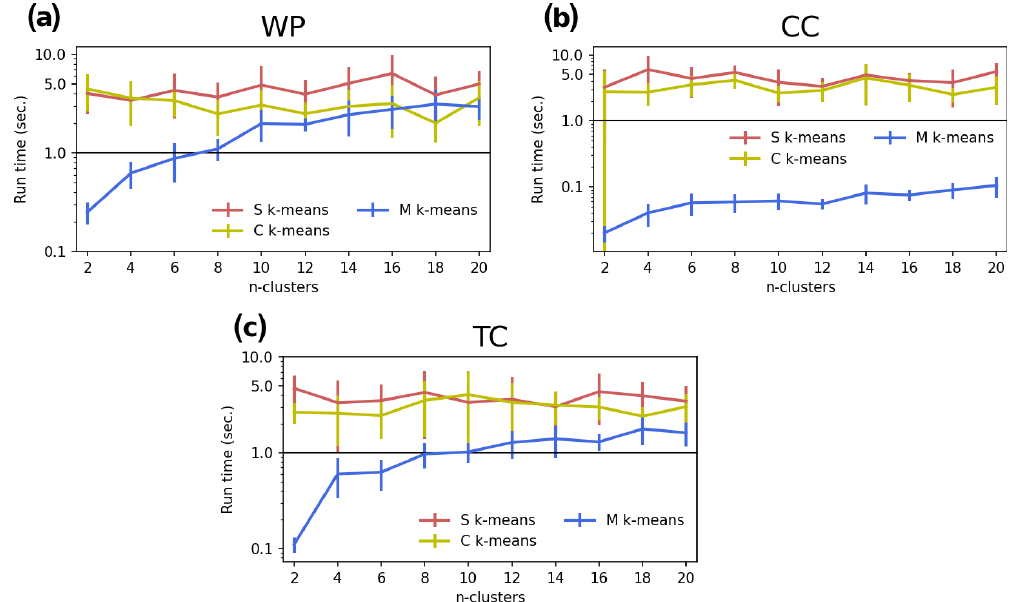
Figure 9. Comparison of the run time (in seconds) of S, C, E, and M k -means for k = 2, 4, ... , 20 for three demonstration experiments: WP (a) , CC (b) , and TC (c) . The uncertainty range in each line indicates the standard deviation of the scores among 10 runs with randomized initializations. Note that the y axis is logarithmically rescaled.